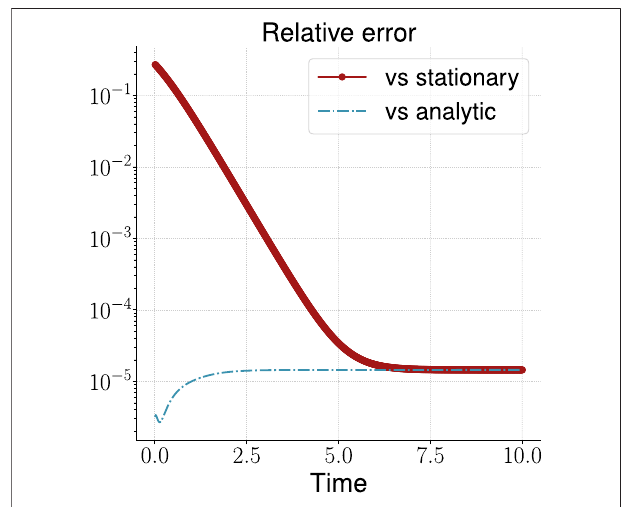
FIGURE 2 | Relative error of the calculated solution vs known analytic and stationary solutions for the one-dimensional